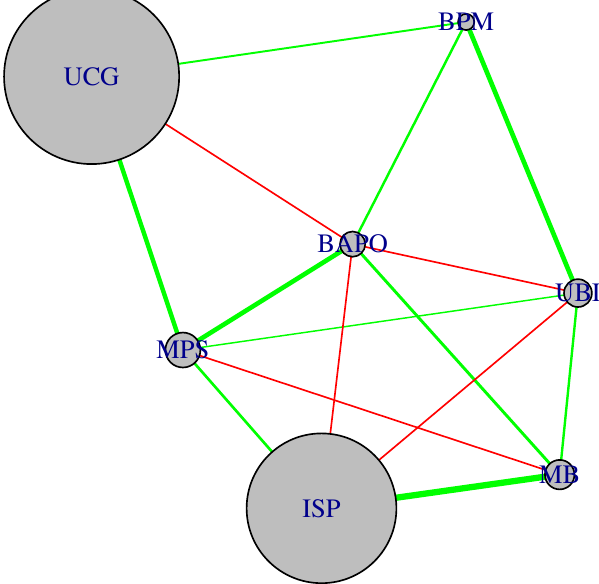
Figure 5. Partial correlation network, Italian banking system, function of assets. Notes: Partial correlation network between seven Italian banks, based on partial correlations between expected losses. The size of each node in the network is proportional to the amount of total assets of the corresponding bank. Green lines indicate positive partial correlations, while red lines stand for negative partial correlations. The thicker the line, the stronger the connection. Non-significant partial correlations have been